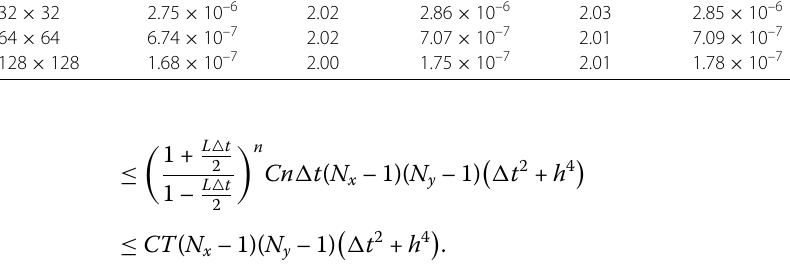
Table 1 Error, order of accuracy with different values of α x and α y for Example 1 α x = α y = 1.4 α x = 1.4, α y = 1.8 α x = α y = 1.8 N x × N y L 2 error Order L 2 error Order L 2 error Order 16 ×